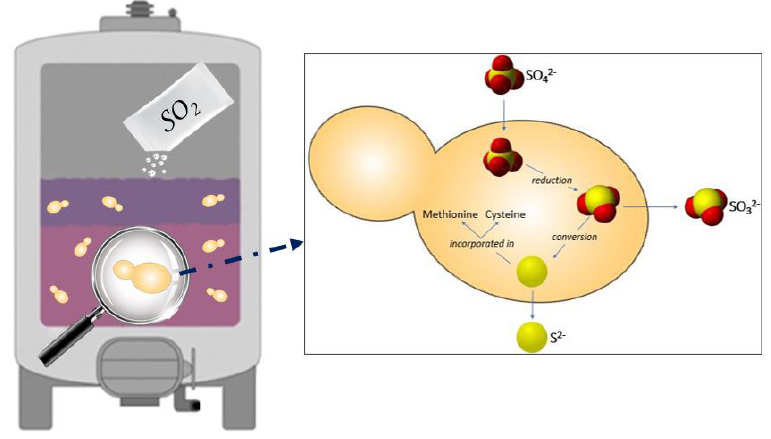
Figure 1. Sulfur metabolism in Saccharomyces cerevisiae yeast cell.